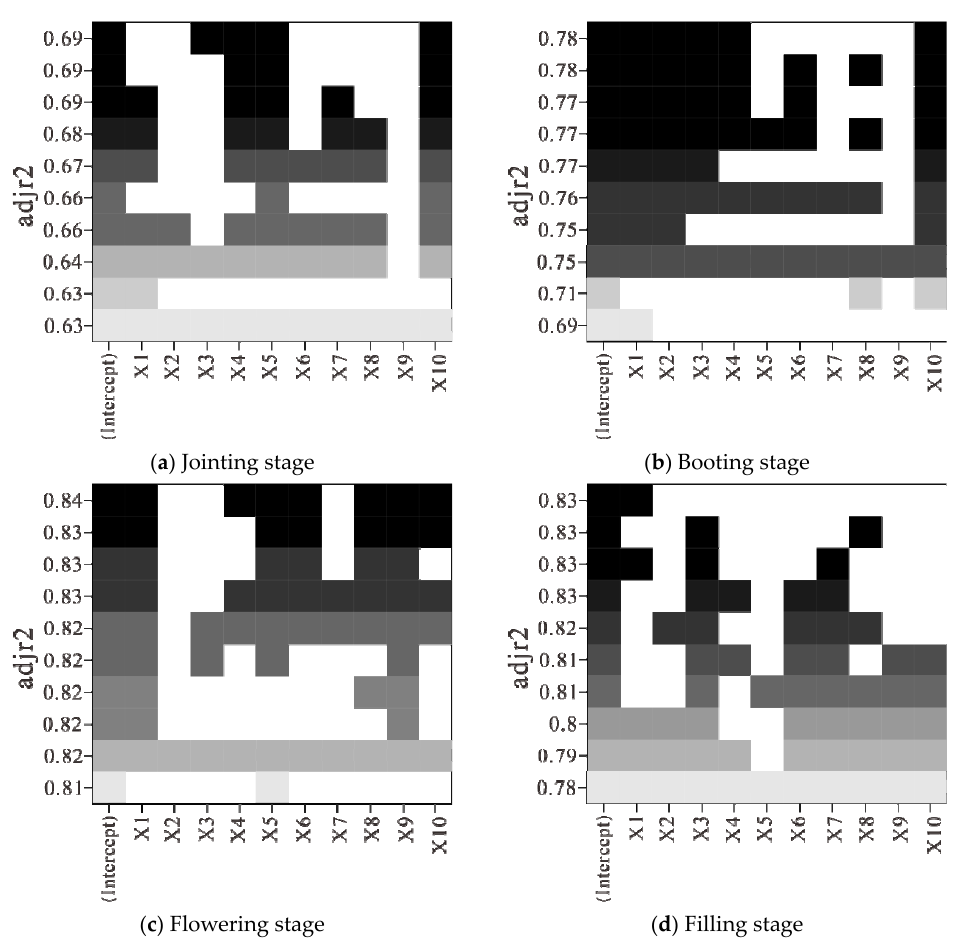
Figure 8. Optimal subset analysis of wavelet energy coefficient for estimating leaf area index at different growth stages.